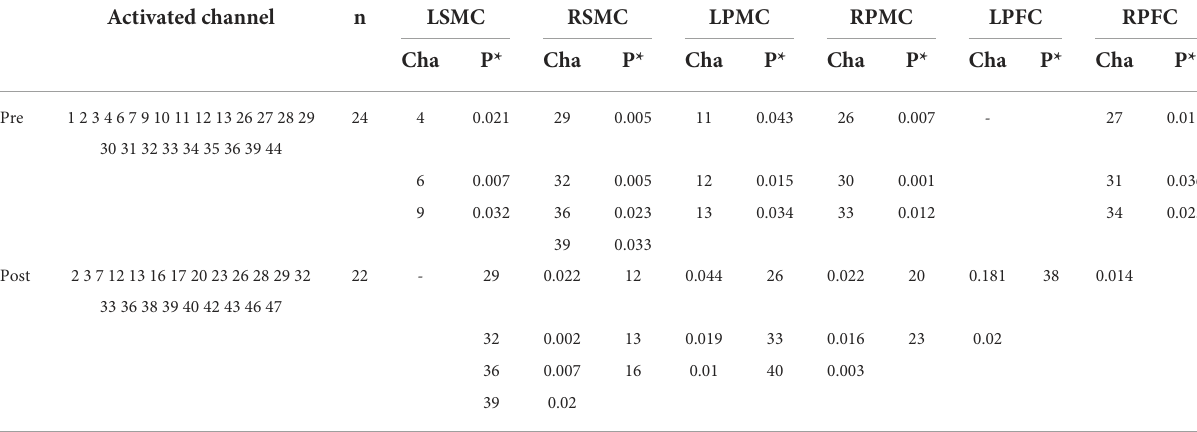
TABLE 4 Activated channels pre and post intervention of all the subjects in group analysis. Activated channel